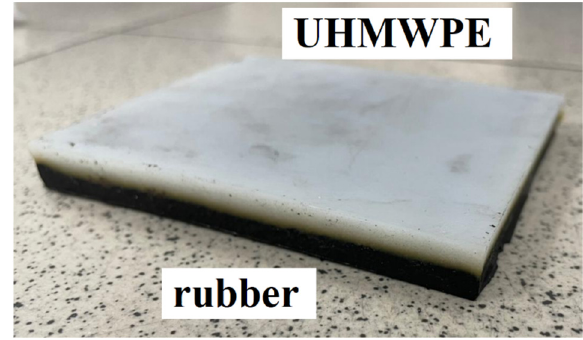
Figure 2. Double layer UHMWPE/elastomer material.